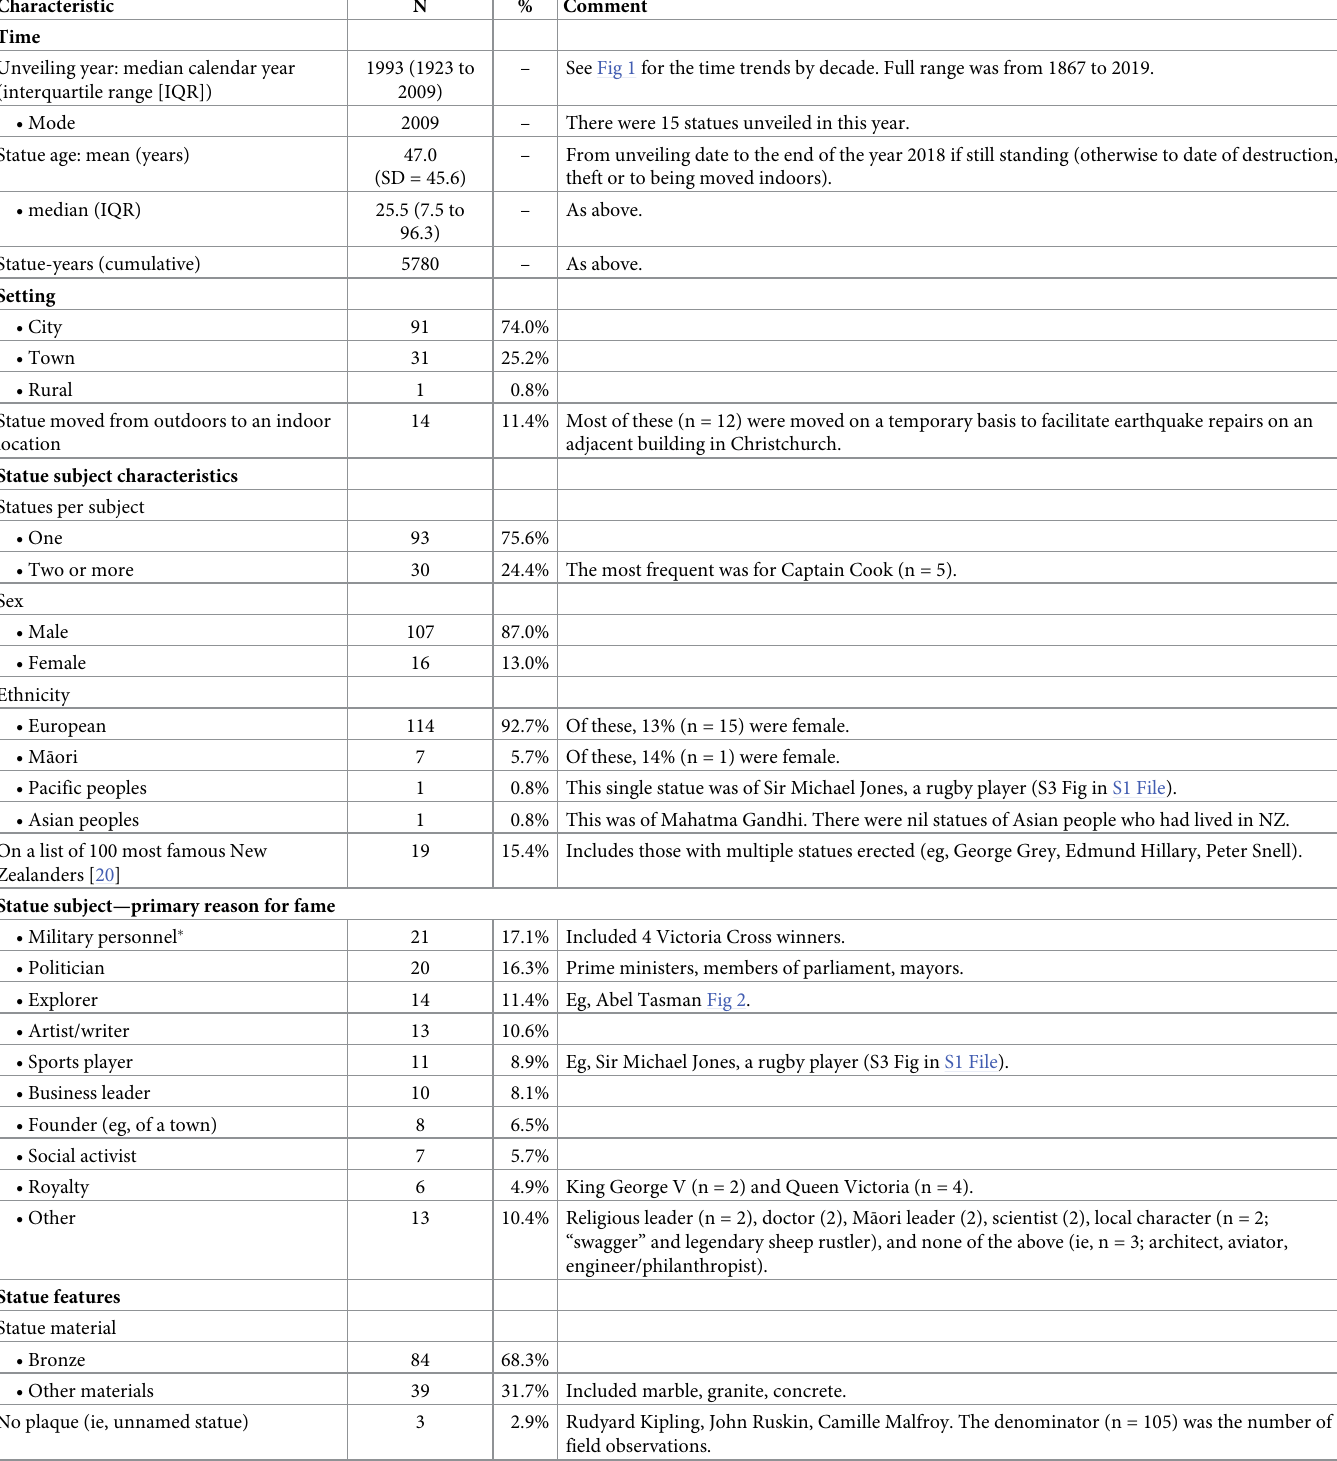
Table 1. Characteristics of all the 123 statues of named people in outdoor public settings throughout identified in this national survey (New Zealand). Characteristic N %